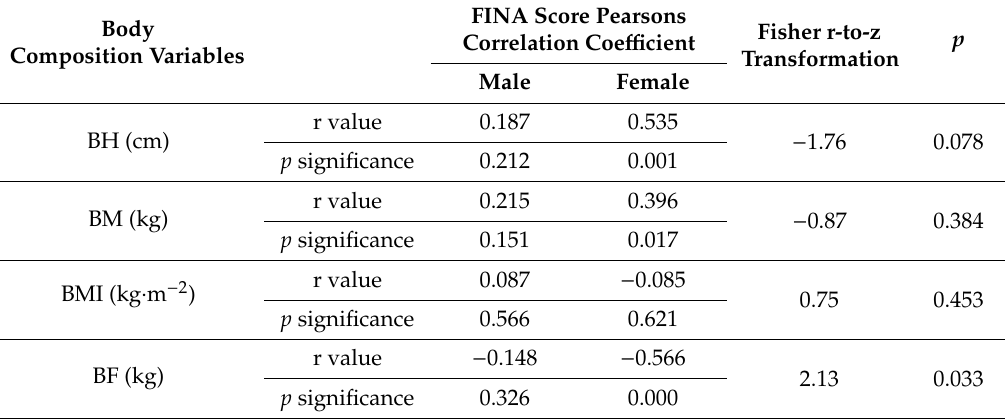
Table 2. Correlation matrix for body composition variables and athletes’ performance with Fisher r-to-z transformation